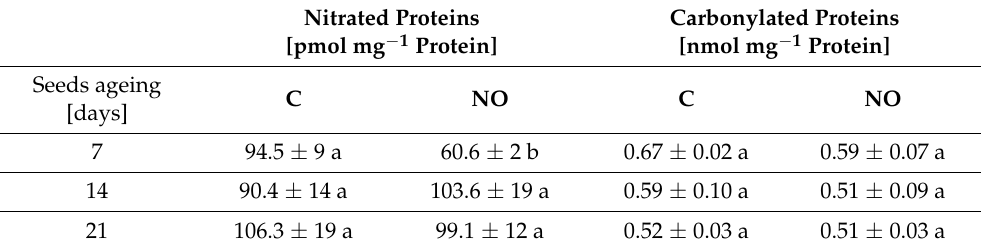
Table 1. The levels of protein nitration and protein carbonylation in the axes of apple embryos isolated from seeds subjected to accelerated ageing for 7, 14 and 21 days (C) or embryos isolated from aged seeds and treated with NO (NO). Values are average ± SD of 3 independent repetitions. Different letters indicate significant differences obtained by Tukey’s test ( p <